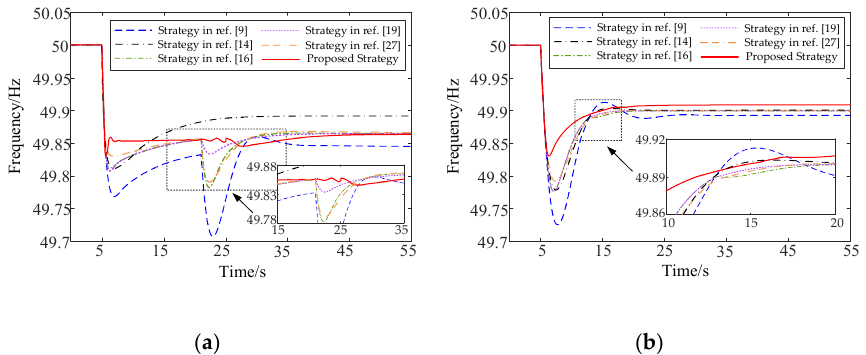
Figure 20. Sending-end system frequency. ( a ) Sending-end system frequency based on the operating conditions of Case 1 and ( b ) sending-end system frequency based on the operating conditions of Case 2.